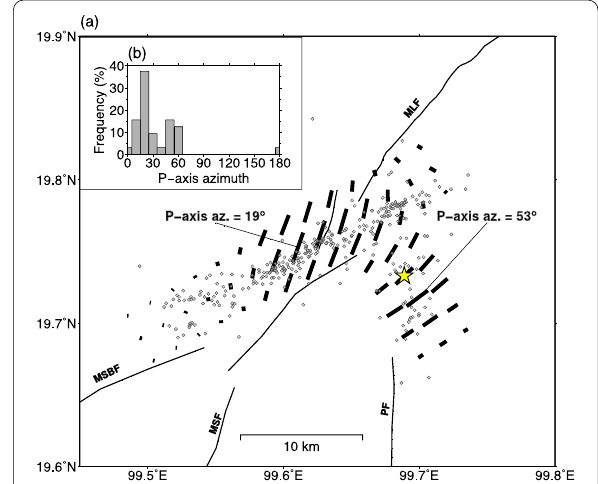
Fig. 7 The P-axis azimuth distribution. a The P-axis azimuth distribution extracted from the resultant potency density tensors of each sub-fault from Fig. 6. The length of the P-axis is proportional to the potency density relating to the color scale of Fig. 6. The azimuth is measured clockwise from north. The yellow star shows the epicenter. The dots show the relocated aftershock (Pananont et al. 2017). The black thin line shows the active faults (DMR 2016; Kanthiya et al. 2019). b The histogram of the P-axis azimuth, counting the ones corresponding to the larger potency density than 25% of the maximum potency density every 10° azimuthal